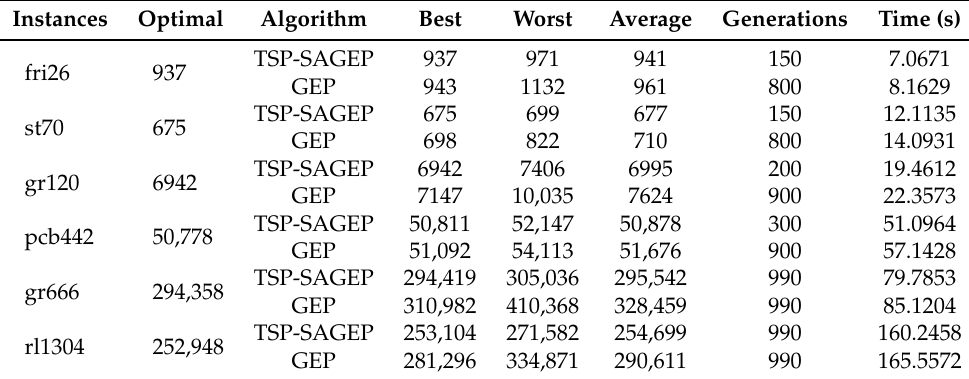
Table 3. Comparison of four measures between TSP-SAGEP and a traditional GEP